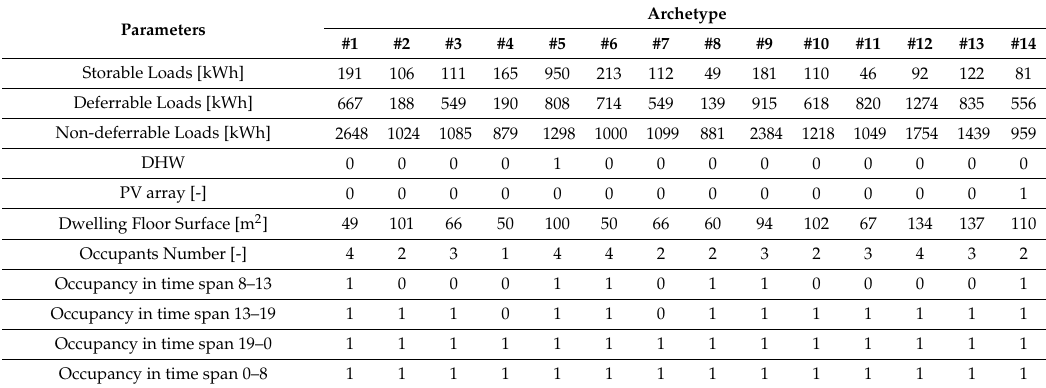
Table 5. Archetypes reference parameters.